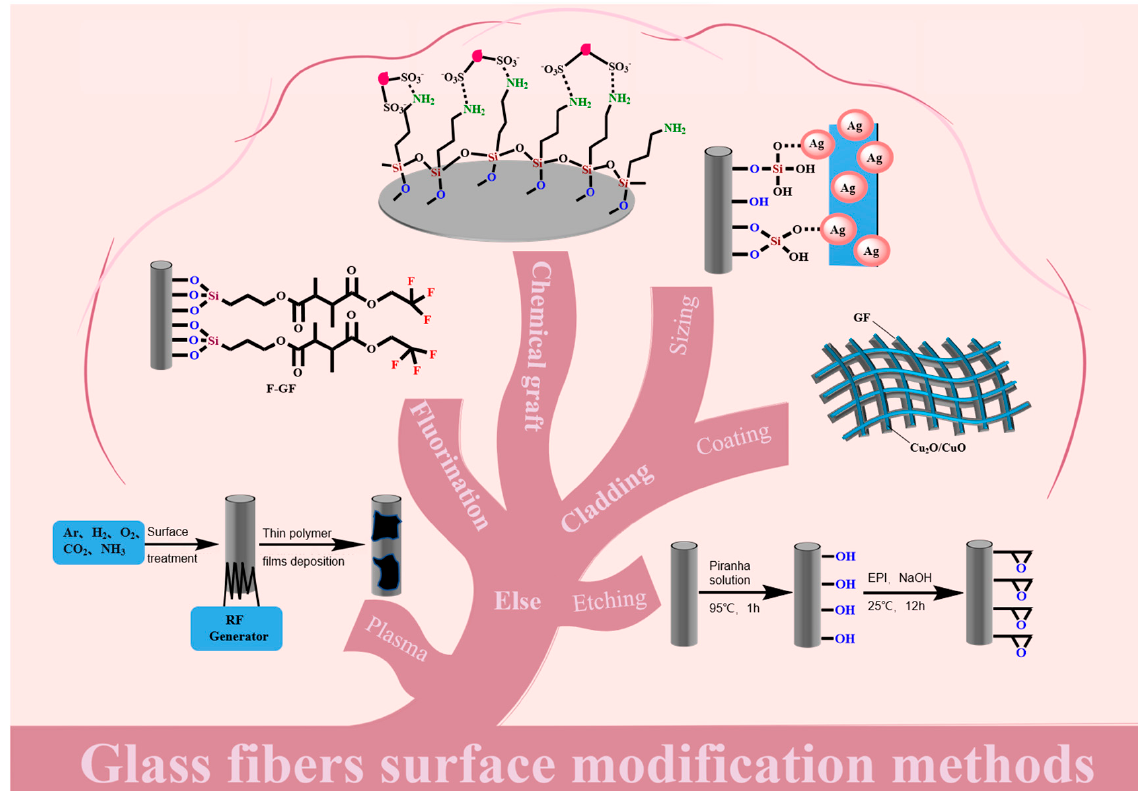
Figure 1. Glass fibers surface modification methods (by Figdraw).